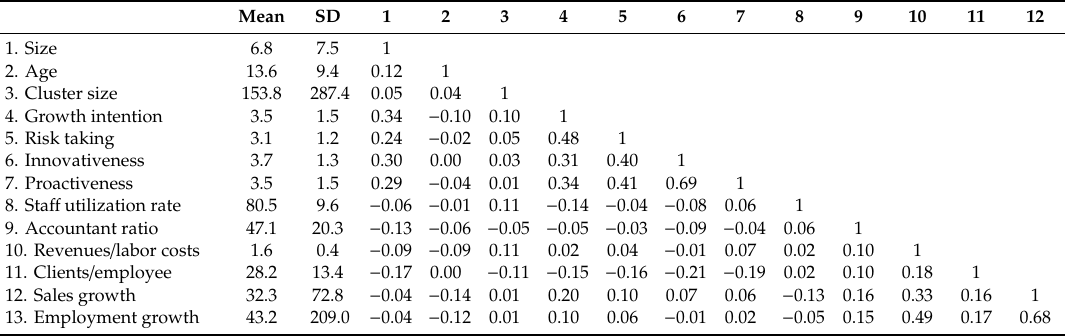
Table 1. Descriptive statistics and correlations among the analysis variables (n =